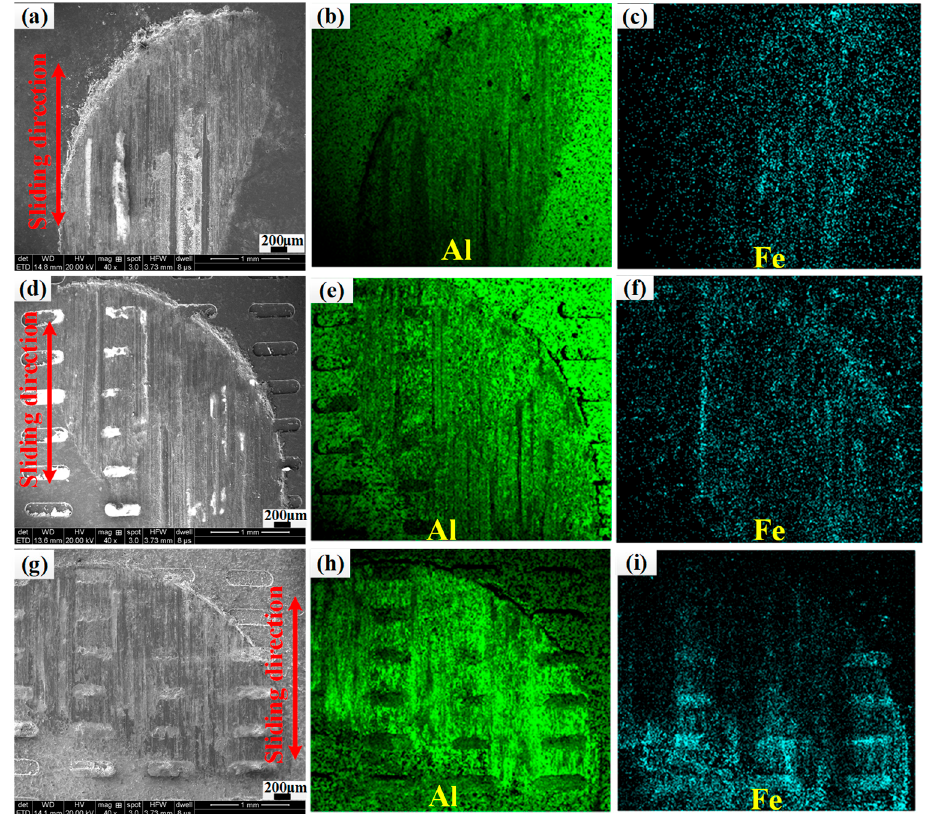
Figure 9. SEM micrographs of flat, micro-textured, and anodizing micro-textured specimens ( a , d , g ) and EDS element mapping data of ( b , e , h ) Al, ( c , f , i ) Fe.